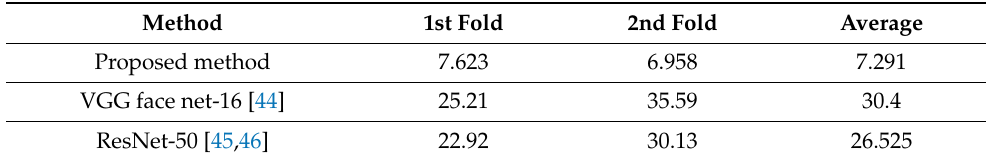
Table 11. Comparison of EERs using the proposed method and the previous face recognition methods (unit: %).